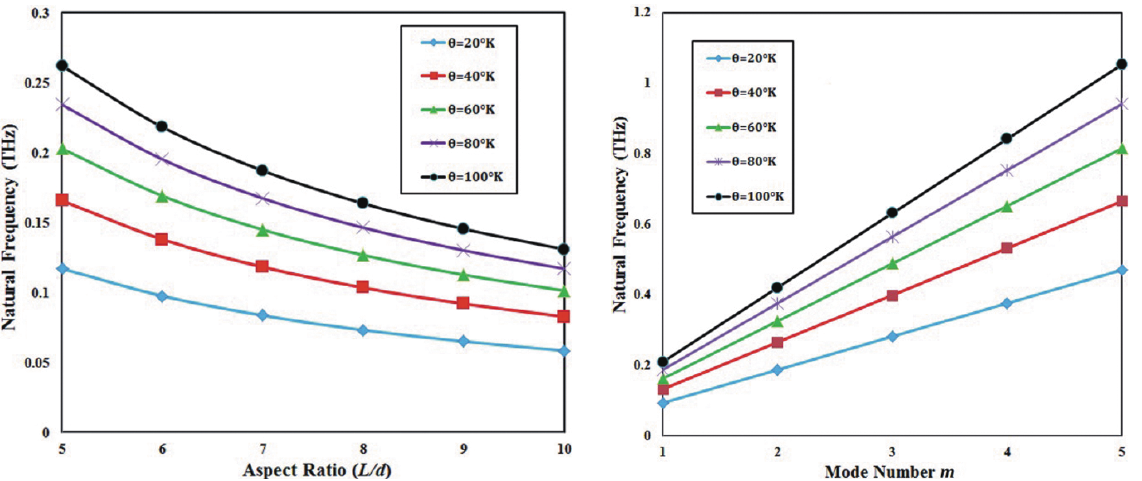
Fig. 8. The natural frequency of a short-SWCNT with different mode number m and shear modulus parameter K G , ( K W = 10 2 N/m 2 , μ = 0 . 5 , L/d = 5).